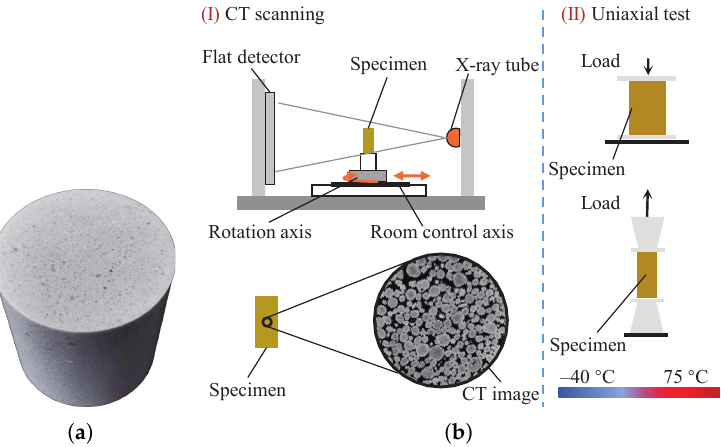
Figure 2. ( a ) A sample of the PBM investigated in this study, and ( b ) schematic diagram of the testing